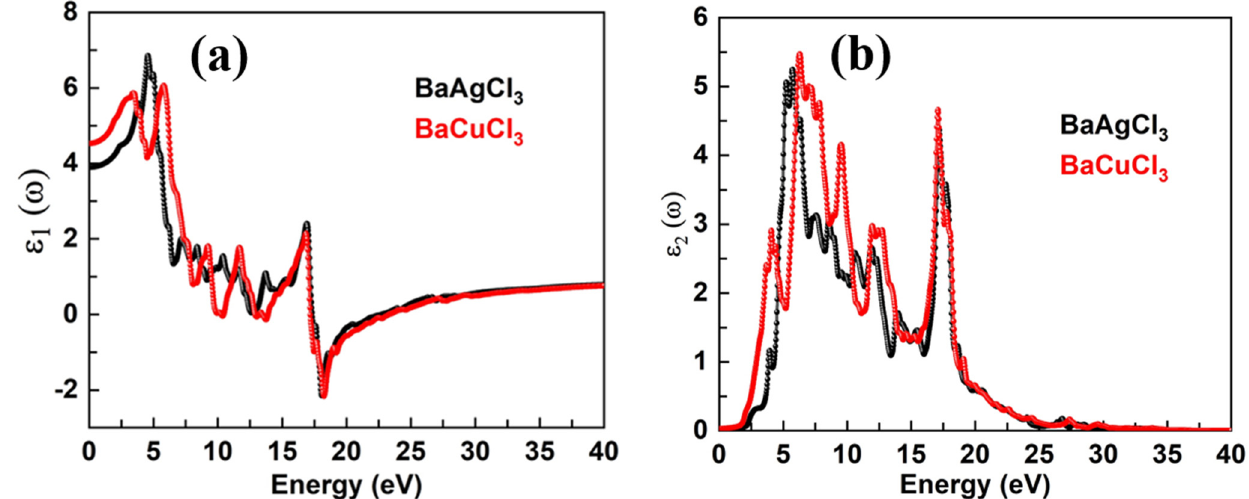
Figure 6. The Complex dielectric functions of ( a ) BaAgCl 3 and ( b ) BaCucCl 3